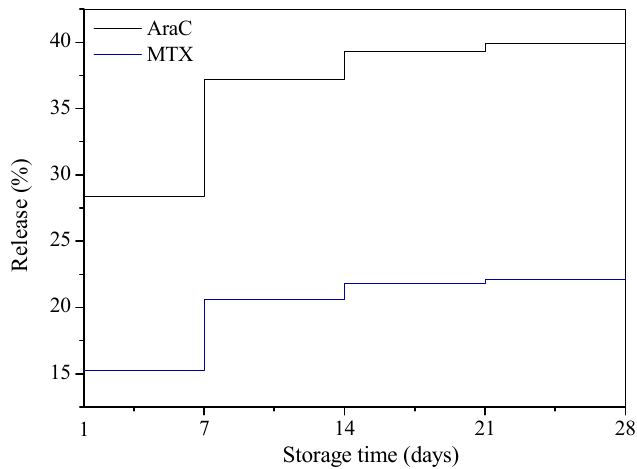
Figure 3. In vitro cytarabine (AraC) and methotrexate (MTX) release from the L DPPC/AraC/MTX liposomes stored at +4 °C for a period of four weeks.